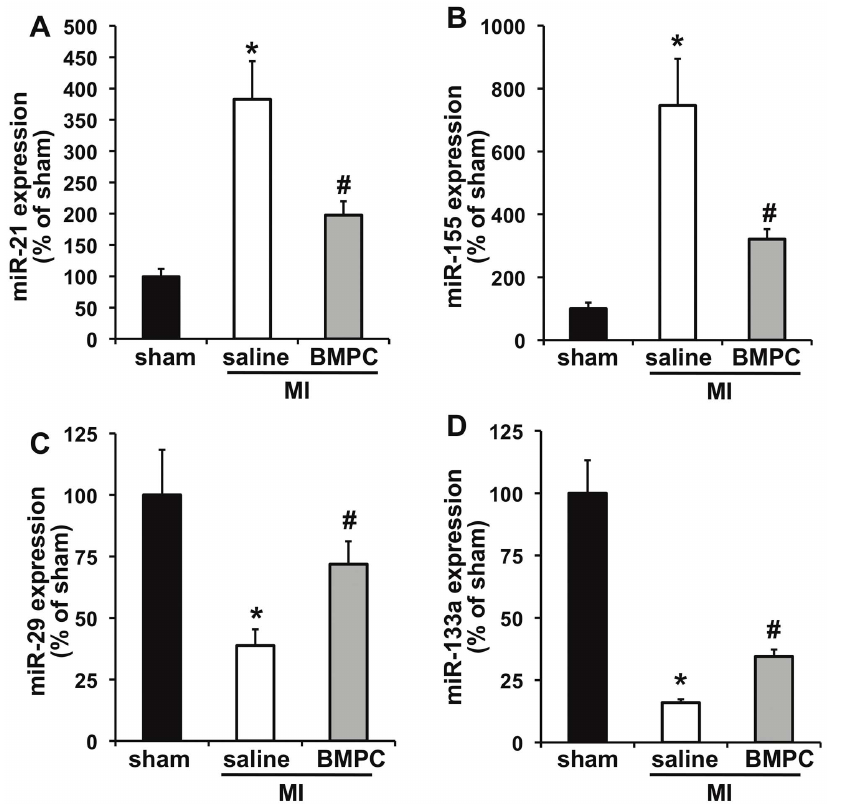
Figure 1. Intramyocardial BMPC transplantation regulates cardiac miRNAs following MI in mice. miRNA expression was measured in the border zone of infarcted area at 3 days post-MI by quantitative RT-PCR. BMPC therapy decreased miR-21 ( A ) and miR-155 ( B ) and increased miR-29 ( C ) and miR-133a ( D ) expression in comparison with saline-treated or sham groups. *P , 0.01 vs sham; # P , 0.05 vs saline group. BMPC-bone marrow- derived progenitor cell; MI, myocardial infarction.